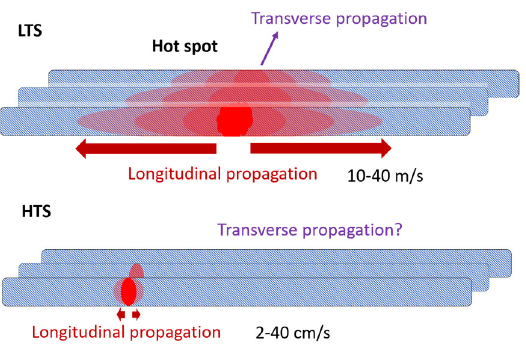
Figure 3. A sketch comparing normal zone propagation specifics in LTS and HTS coils.